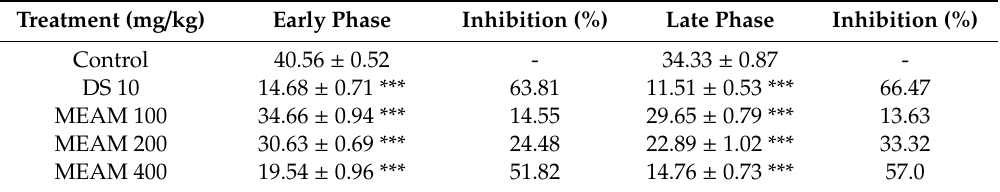
Table 3. Analgesic e ff ect of methanol extract of A. montanum (MEAM) and diclofenac sodium (DS) in formalin-induced paw licking test in mice.